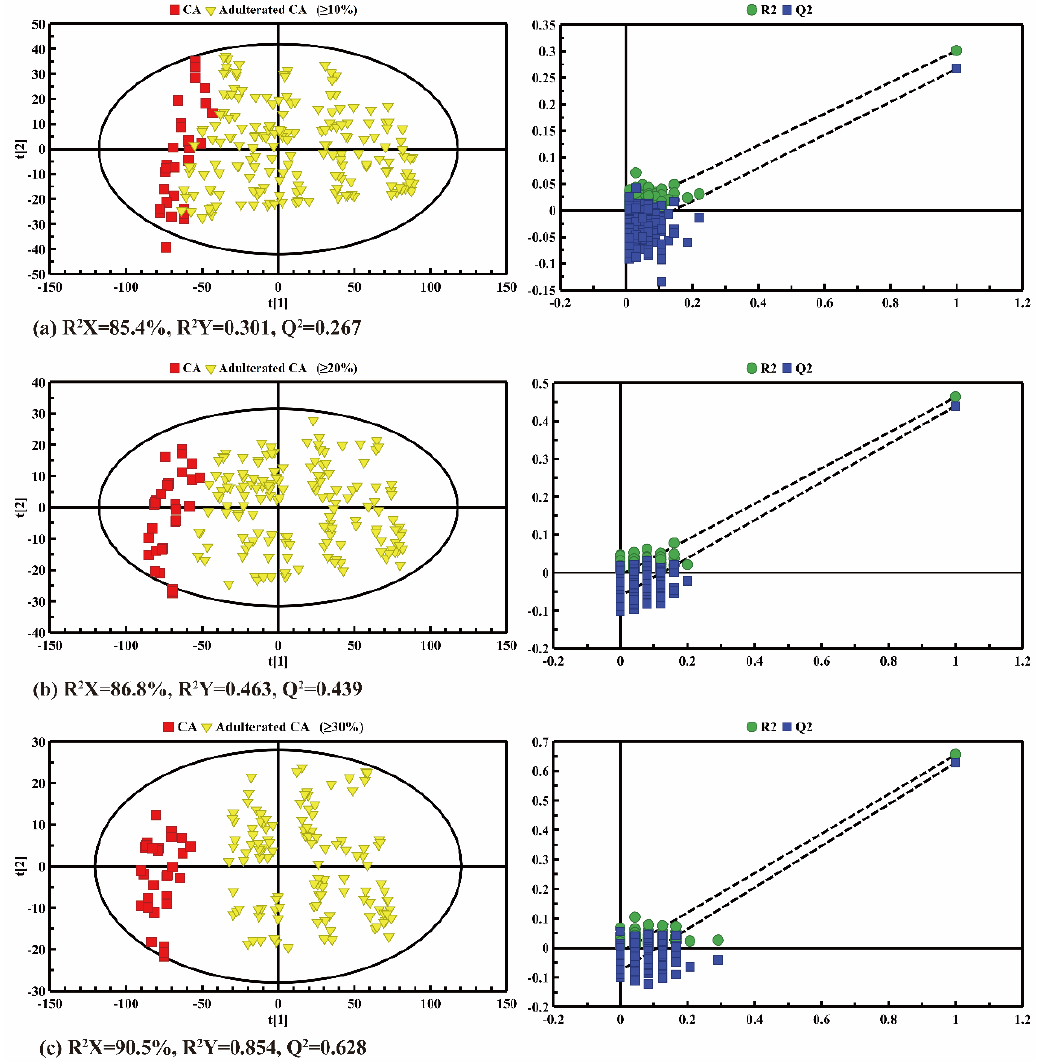
Figure 6. PLS-DA score plots (left panel) and cross validation plots (right panel) by permutation test ( n = 200) between the pure camellia oil (CA) and the CA adulterated with different adulteration ratios ranging from ( a ) 10% to 100%; ( b ) 20% to 100% and ( c ) 30% to 100%.